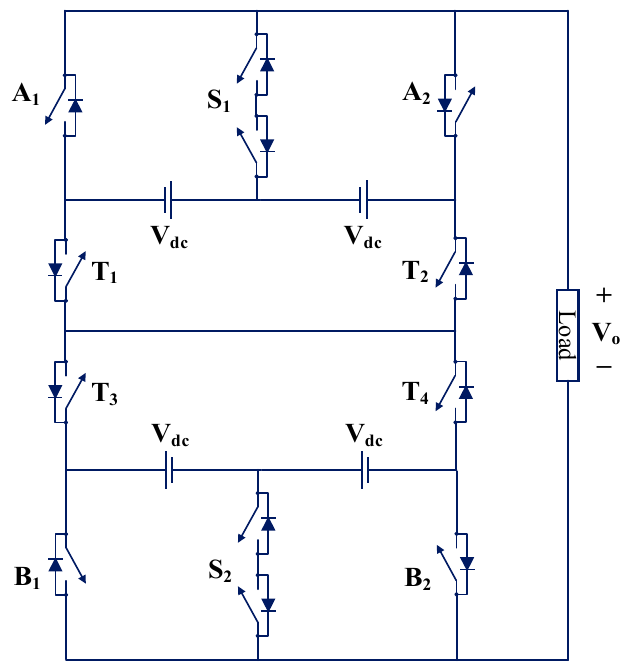
Figure 35. Single-phase nine-level FT MLI (TP38) [70].